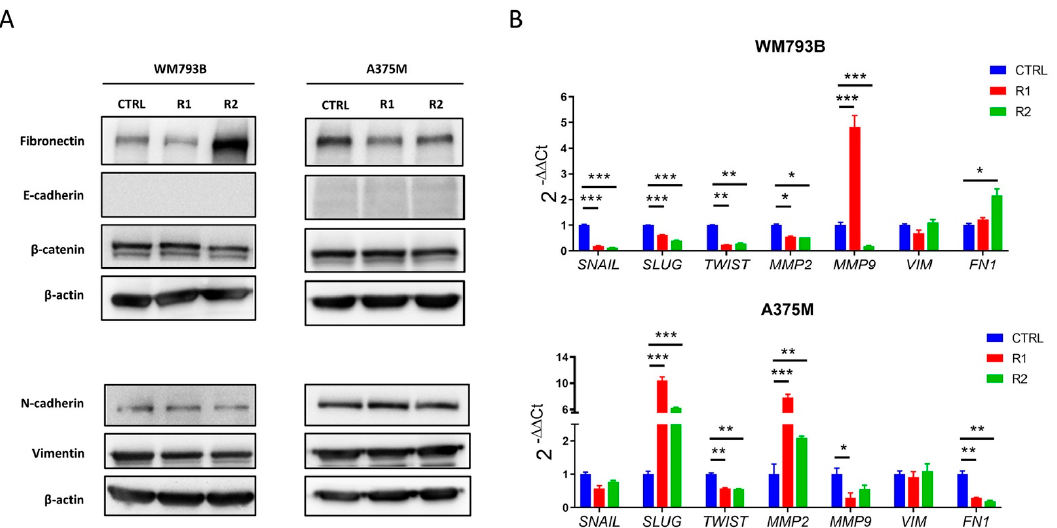
Figure 3. EMT marker expression in parental (CTRL) and resistant (R) WM793B and A375M cell lines. ( A ) The expression of EMT markers at the protein level was investigated by western blotting. β -actin was used as a loading control. ( B ) The gene expression levels of EMT markers were measured by q-PCR. The D’Agostino–Pearson test was used to confirm the normal distribution of continuous variables, while the parametric statistical test one-way ANOVA with the Tukey Kramer post hoc method was used to determine a statistically significant difference in the expression between subgroups. Statistical analysis was performed using MedCalc (v. 18.11.3). Statistically significant results are marked by an asterisk (*). A p -value less than 0.05 is flagged with one star (*), a p -value less than 0.01 is flagged with two stars (**), and p -value less than 0.001 is flagged with three stars (***).